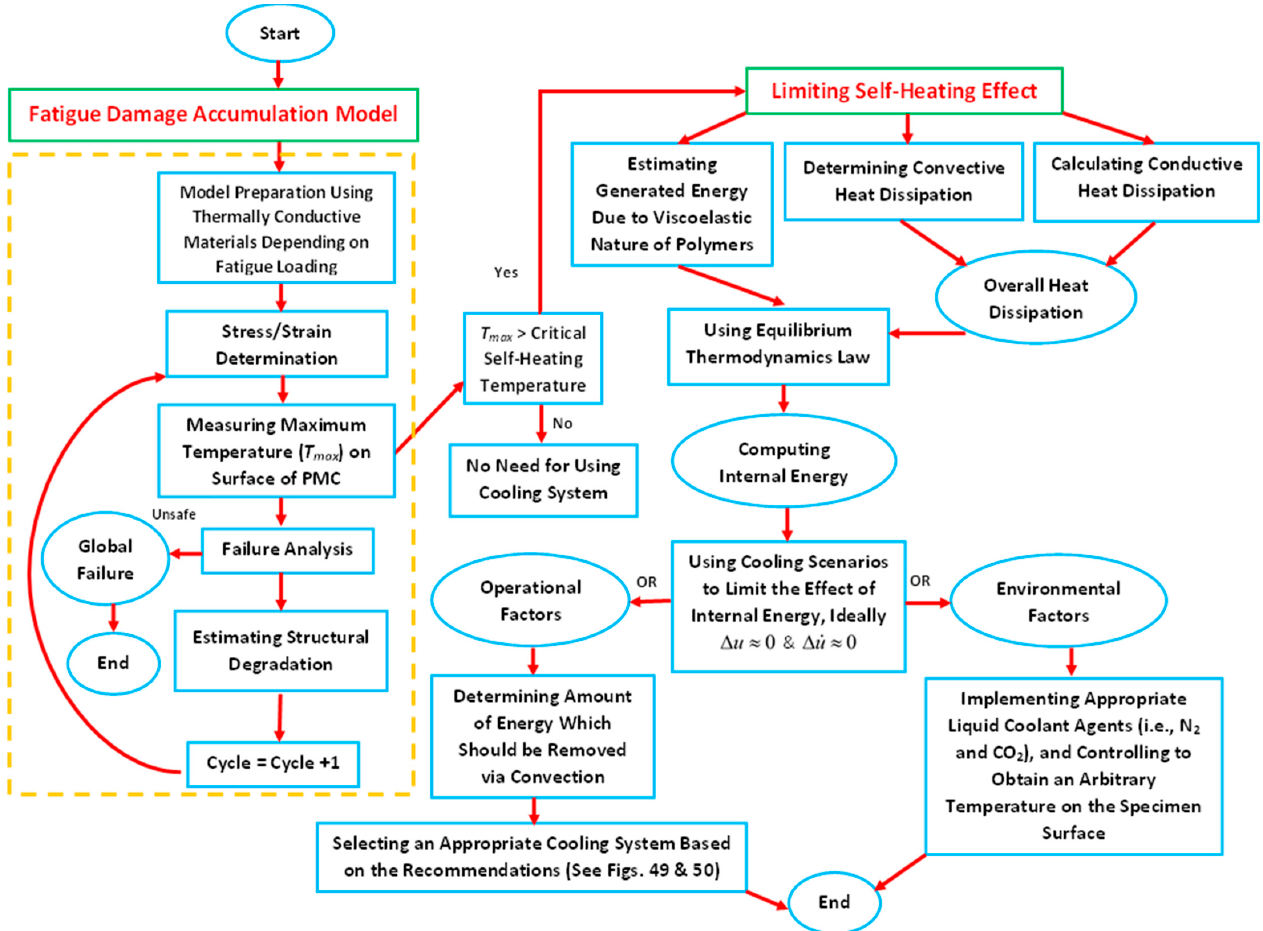
Figure 68. Schematic model for estimating structural degradation and preventing the appearance of self-heating phenomenon using cooling scenarios.